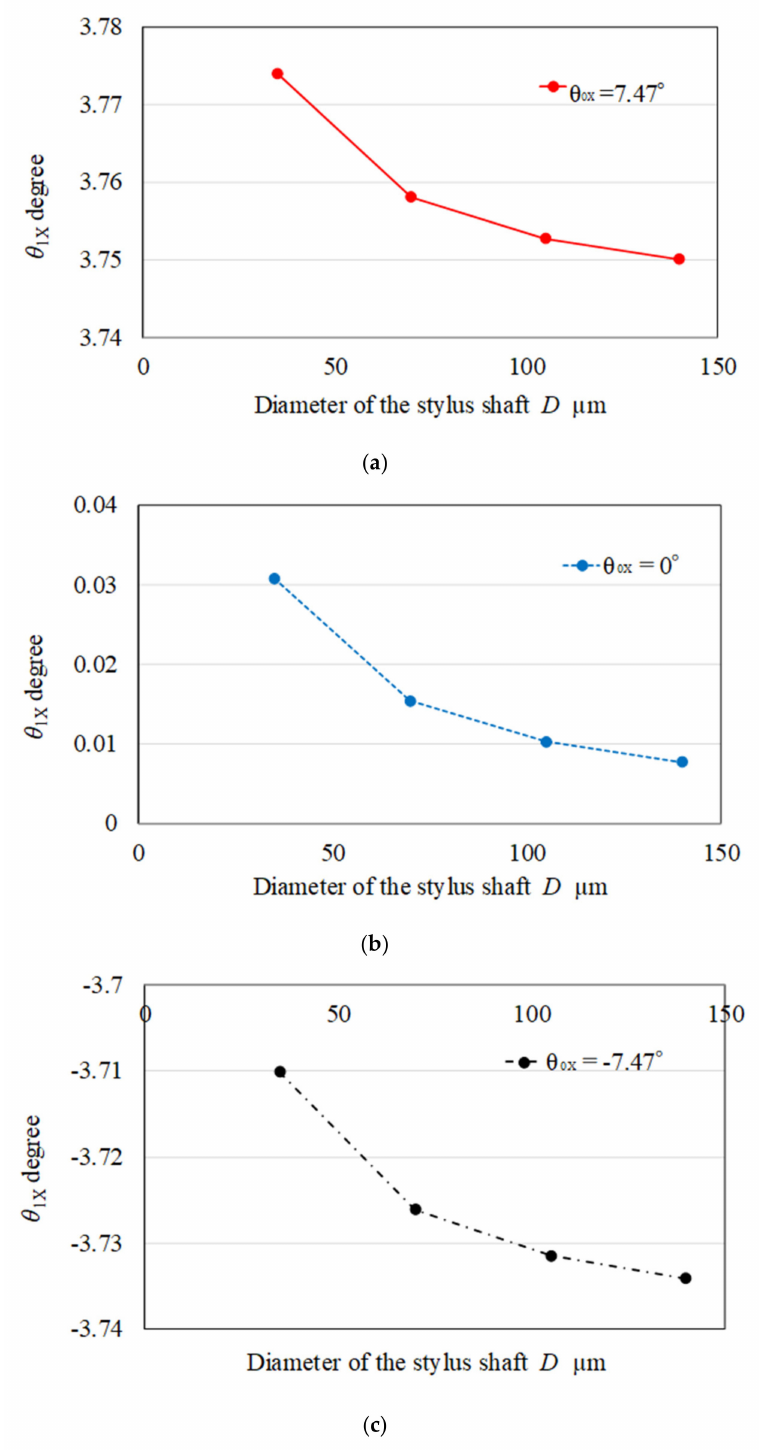
Figure 9. Simulated values of θ 1X (displacement of the stylus shaft along Y-axis = 0.03 µ m). ( a ) θ 0X = 7.47 ◦ ; ( b ) θ 0X = 0 ◦ ; ( c ) θ 0X = − 7.47 ◦